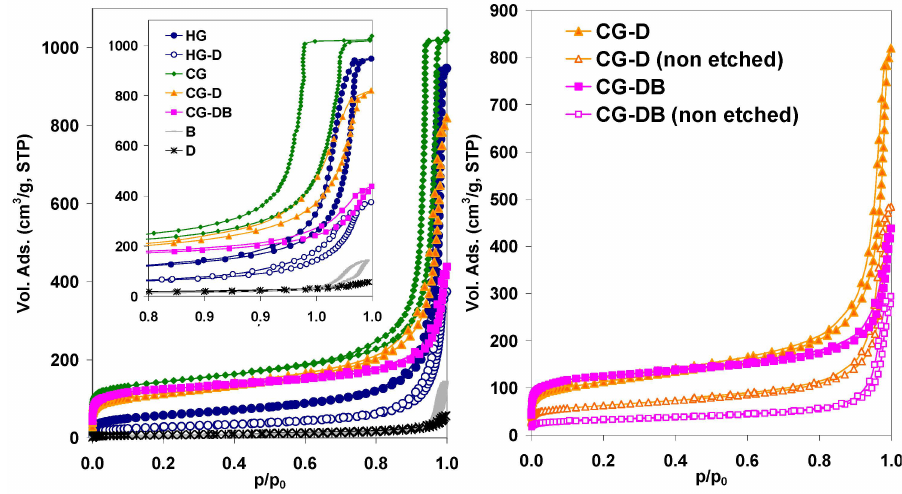
Figure 4. N 2 adsorption isotherms at ´ 196 ˝ C of the studied aerogels (inset: magnification of the high relative pressure range to show the difference in the hysteresis loops). Data corresponding to the additives (diatomite and carbon black) is also included for